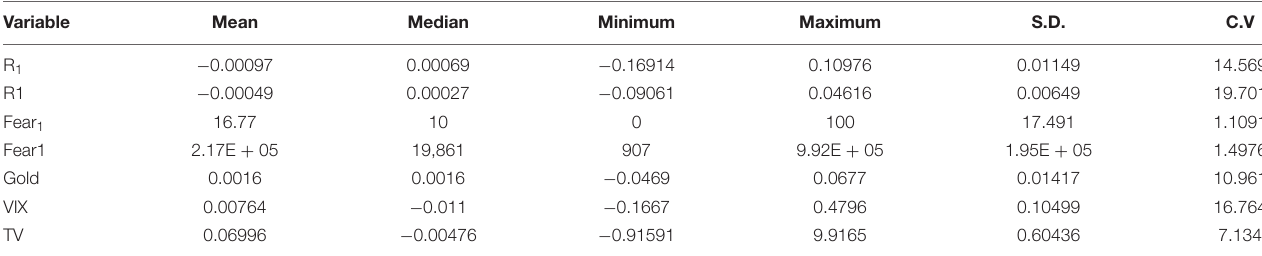
TABLE 4 | The targeted variables’ descriptive statistics.